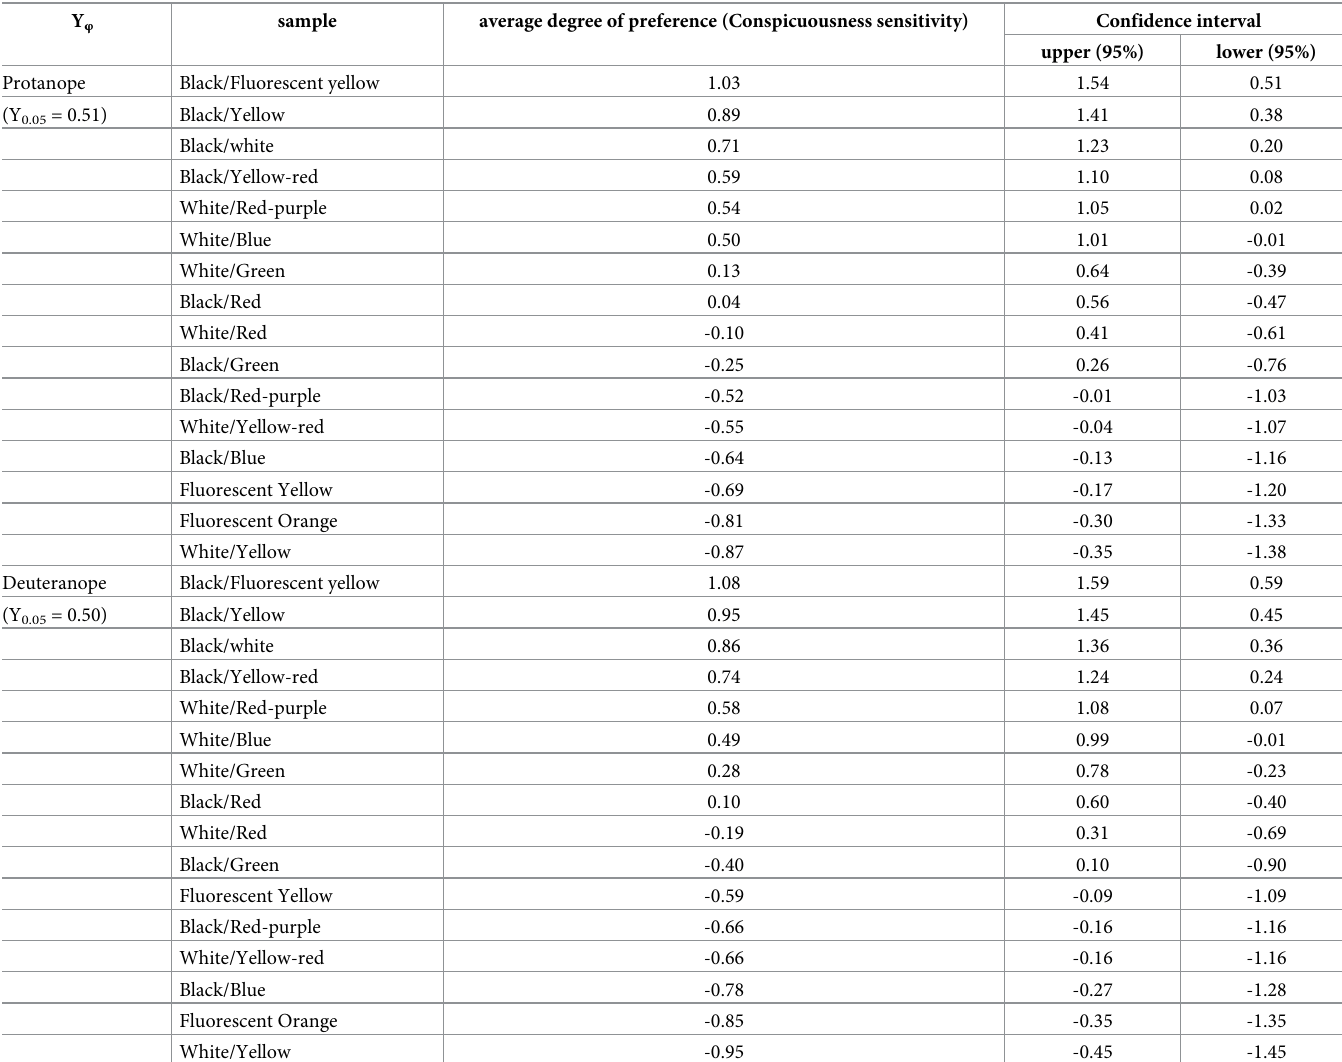
Table 5. Results of 95% confidence intervals and average degree of preference(Conspicuousness sensitivity) for the sample using Scheffe´’s method. Y